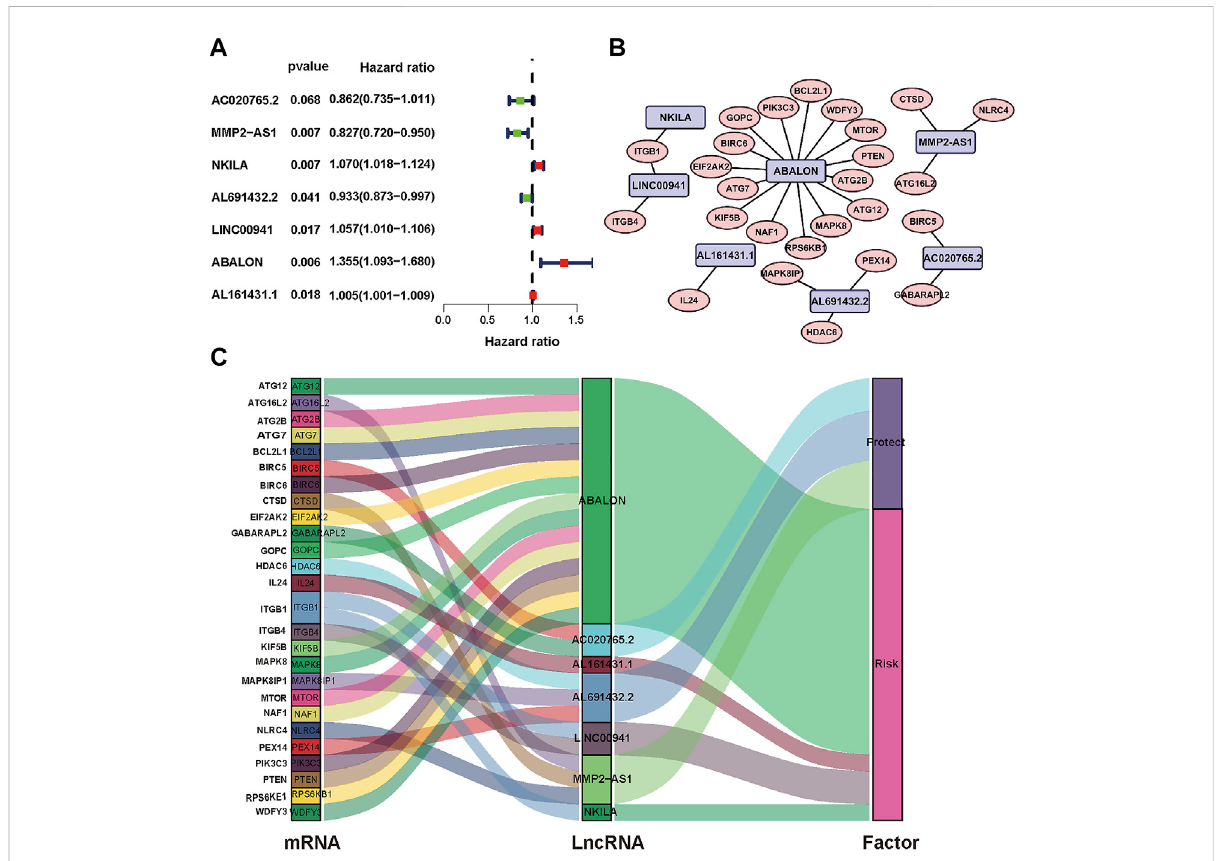
FIGURE 2 Identi fi cation of prognostic autophagy-associated lncRNAs in NSCLC patients. (A) Multivariate Cox analysis to establish the prognostic signature. (B) Establishment of the co-expression network in NSCLC. Blue represents lncRNAs and pink represents mRNAs. (C) The Sankey diagram shows the connection degree between 26 mRNAs and 7 autophagy-associated